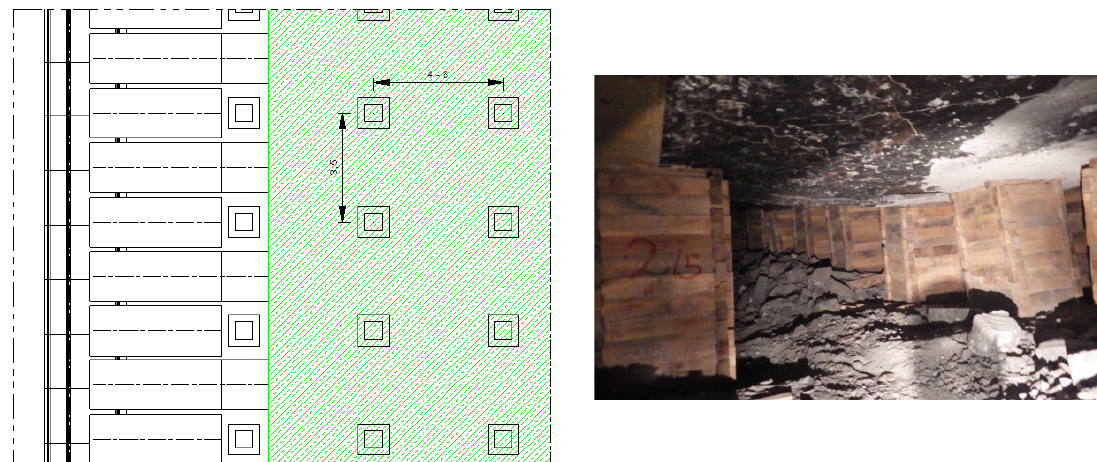
Figure 4: Spacing of box crib behind the powered roof support.